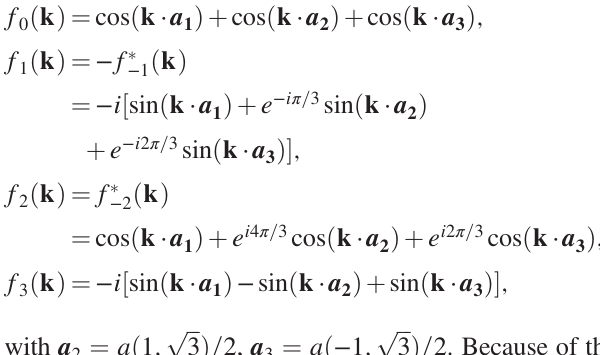
ffiffiffi p 3 Þ = 2 . Because of